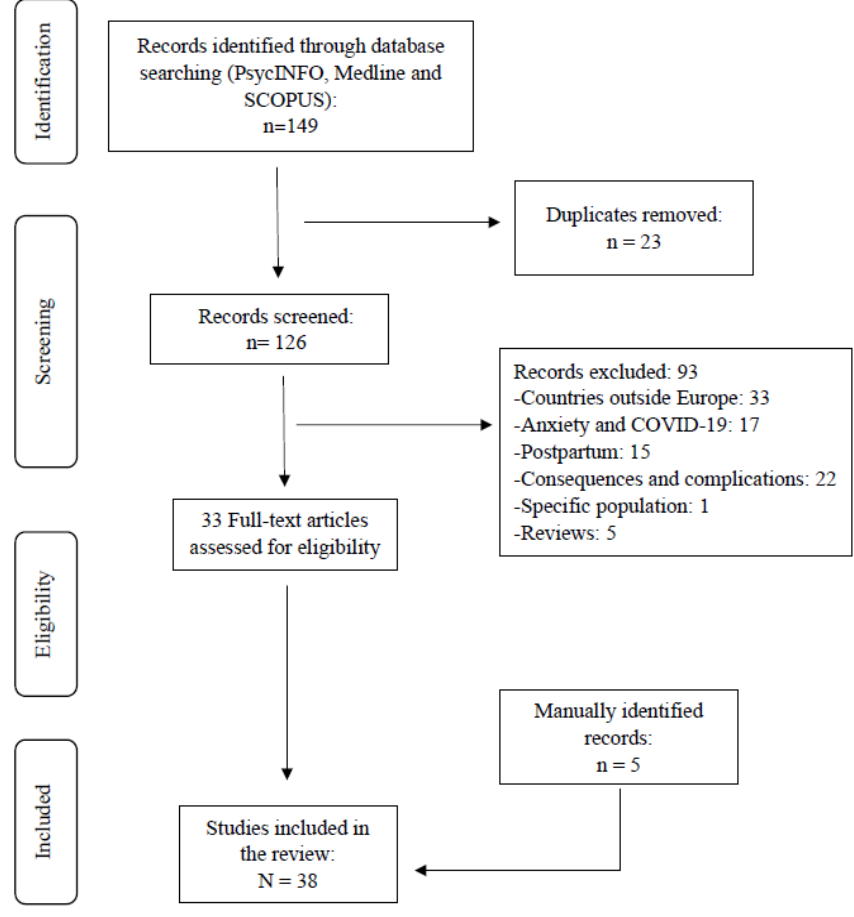
Figure 1. Flowchart of study selection.